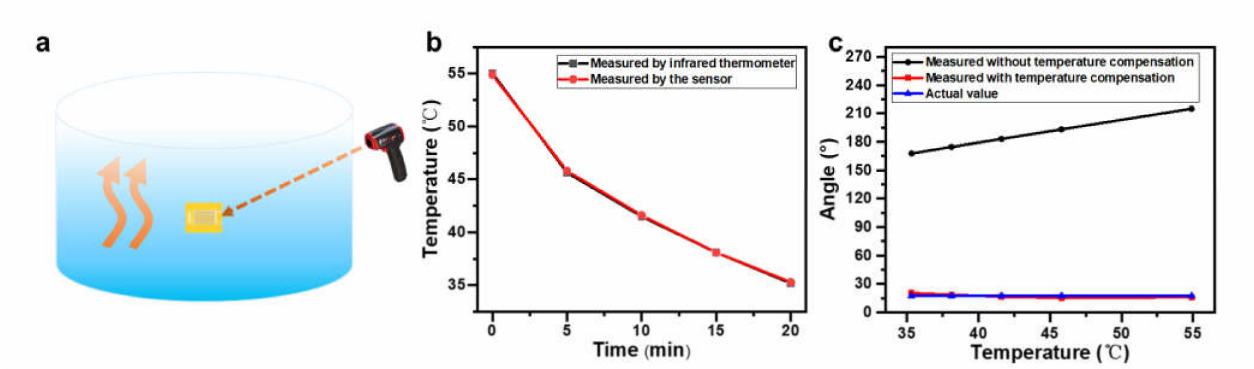
Figure 10. ( a ) Schematic diagram of a two-sensor system attached to the surface of a cylindrical container filled with hot water. ( b ) Temperature change over time measured on the container surface by an infrared thermometer and temperature sensor. ( c ) Angle measured on the container surface at different temperatures with and without temperature compensations. The actual angle value of the container is also plotted as a